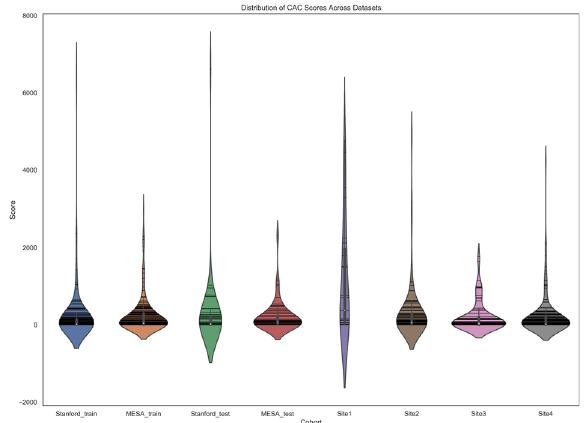
Fig. 9 CAC score distribution across internal and external sites used for the non-gated model. Violin plots show median (white point), each data point (horizontal lines), and interquartile range (vertical gray bar). Note that though the plots extension below a CAC score of 0 re fl ects properties of the kernel density estimator associated with violin plots. CAC score of less than 0 would not be